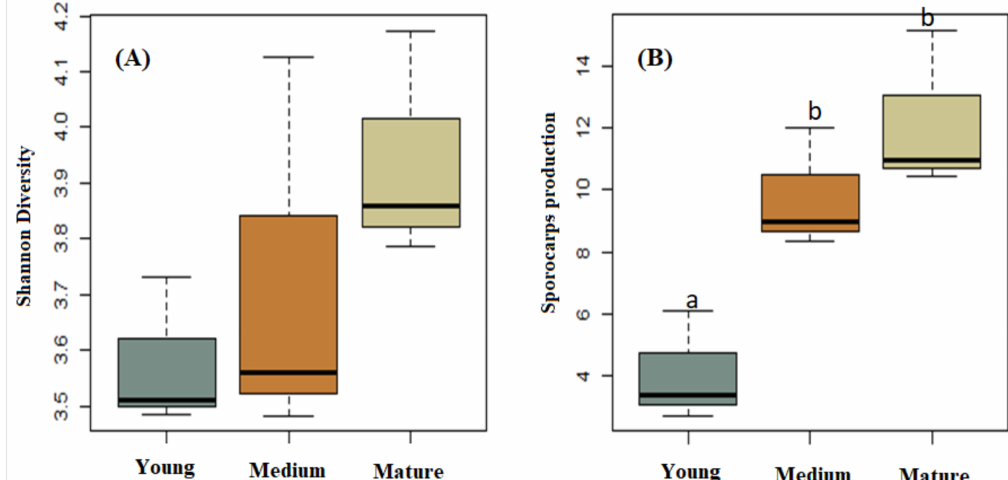
Figure 3. Shannon’s H (cid:48) diversity ( A ) and total sporocarp production (kg ha − 1 ) ( B ) of macrofungal species collected from young, medium-aged, and mature Pinus radiata stands in Menagesha Suba, central Showa, Oromia National Regional State, Ethiopia. Boxplot data showing the max and min values. The bar in the box is the standard deviation of the mean. Values with the same letter are not significantly